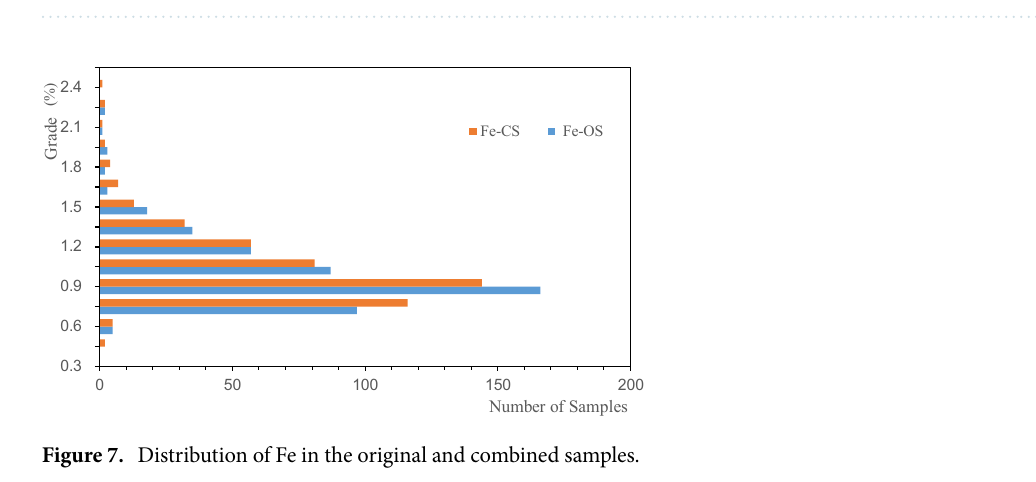
Figure 6. Distribution of Al in the original and combined samples.